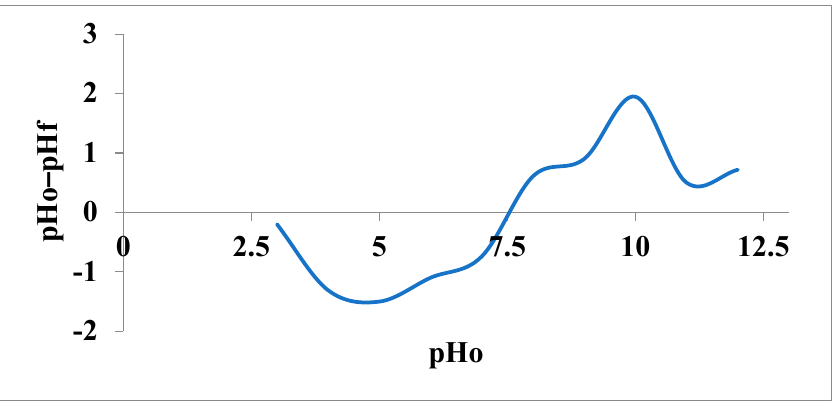
Figure 1. TMS adsorbent’s point of zero charge (pHpzc).